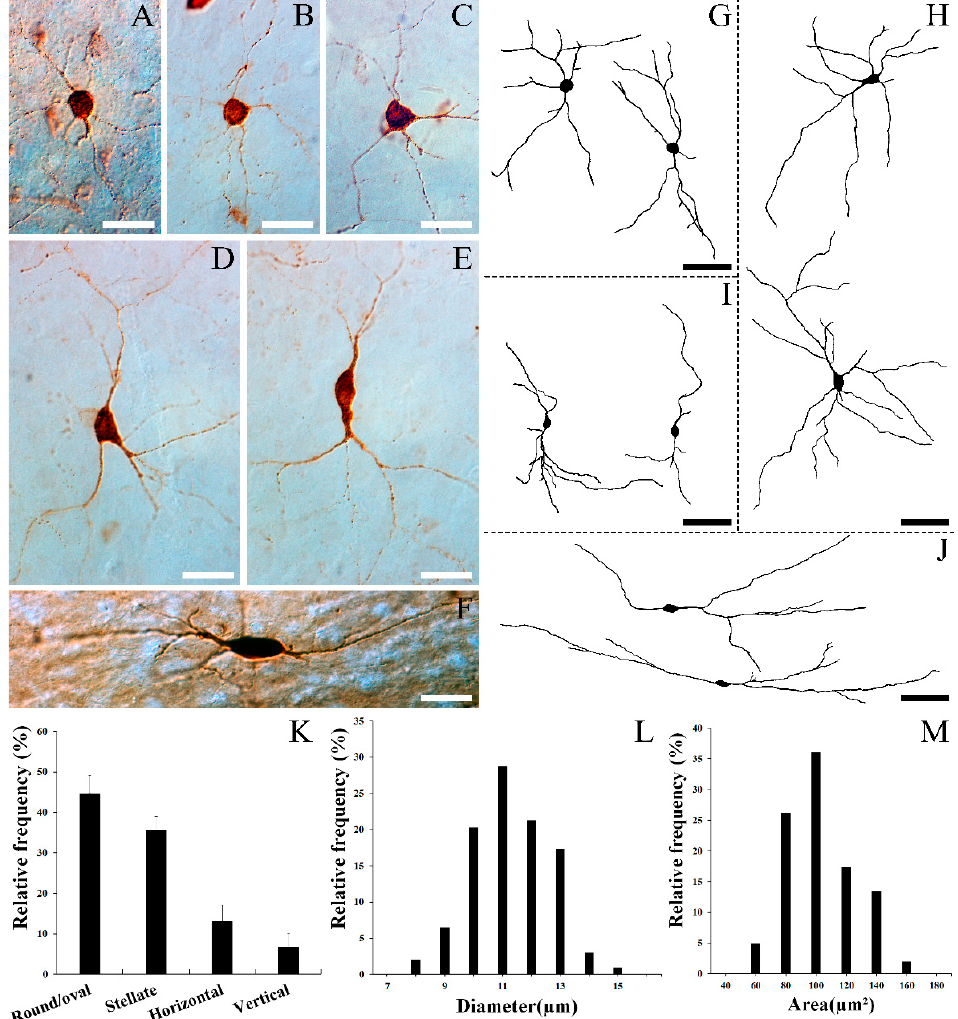
Figure 2. Images of SST neurons’ morphologies and quantitative data in the gerbil VC. DIC photomicrographs ( A – F ) and drawings ( G – J ). ( A , B , G ) Multipolar round/oval cell. ( C , D , H ) Multipolar stellate cell. ( E , I ) Vertical fusiform cell. ( F , J ) Horizontal cell. Although the drawings are copies based on the best-stained cells, note that cell depictions may not be realistic due to the limitations of immunocytochemistry, such as imperfect filling of the whole cell body and trimming of fibers. ( K ) Histogram of the morphological distribution of SST neurons in the gerbil VC. Multipolar round/oval cells were the most commonly found. The average diameter ( L ) and area ( M ) of SST neurons in the gerbil VC were calculated. The average diameter ranged from 7.50 to 14.48 µ m, with a mean of 10.81 µ m (S.D. = 1.34). The average area of these cells ranged from 44.20 to 153.12 µ m 2 , with a mean of 93 µ m 2 (S.D. = 22.70). The error bars represent standard deviation (S.D.). Scale bar = 20 ( A – F ) and 50 µ m ( G – J ). Figure 2K reveals the relative frequency of each cell type in the gerbil VC. Quantita- tively, 44.62% ± 3.94% (mean ± S.D.) (249 of 558 cells) of SST neurons were